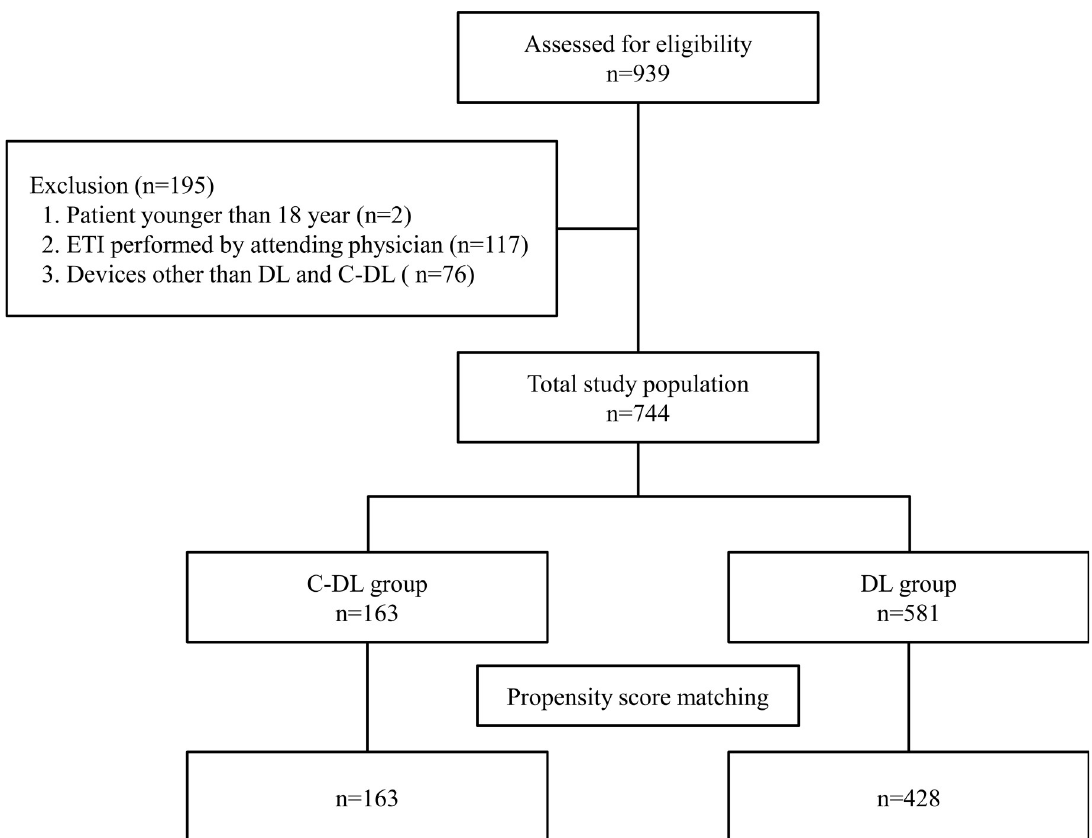
Fig 1. Flow diagram of patients included in the analysis. ETI, endotracheal intubation; DL, conventional direct laryngoscope; C-DL, C-MAC used as a direct laryngoscope.